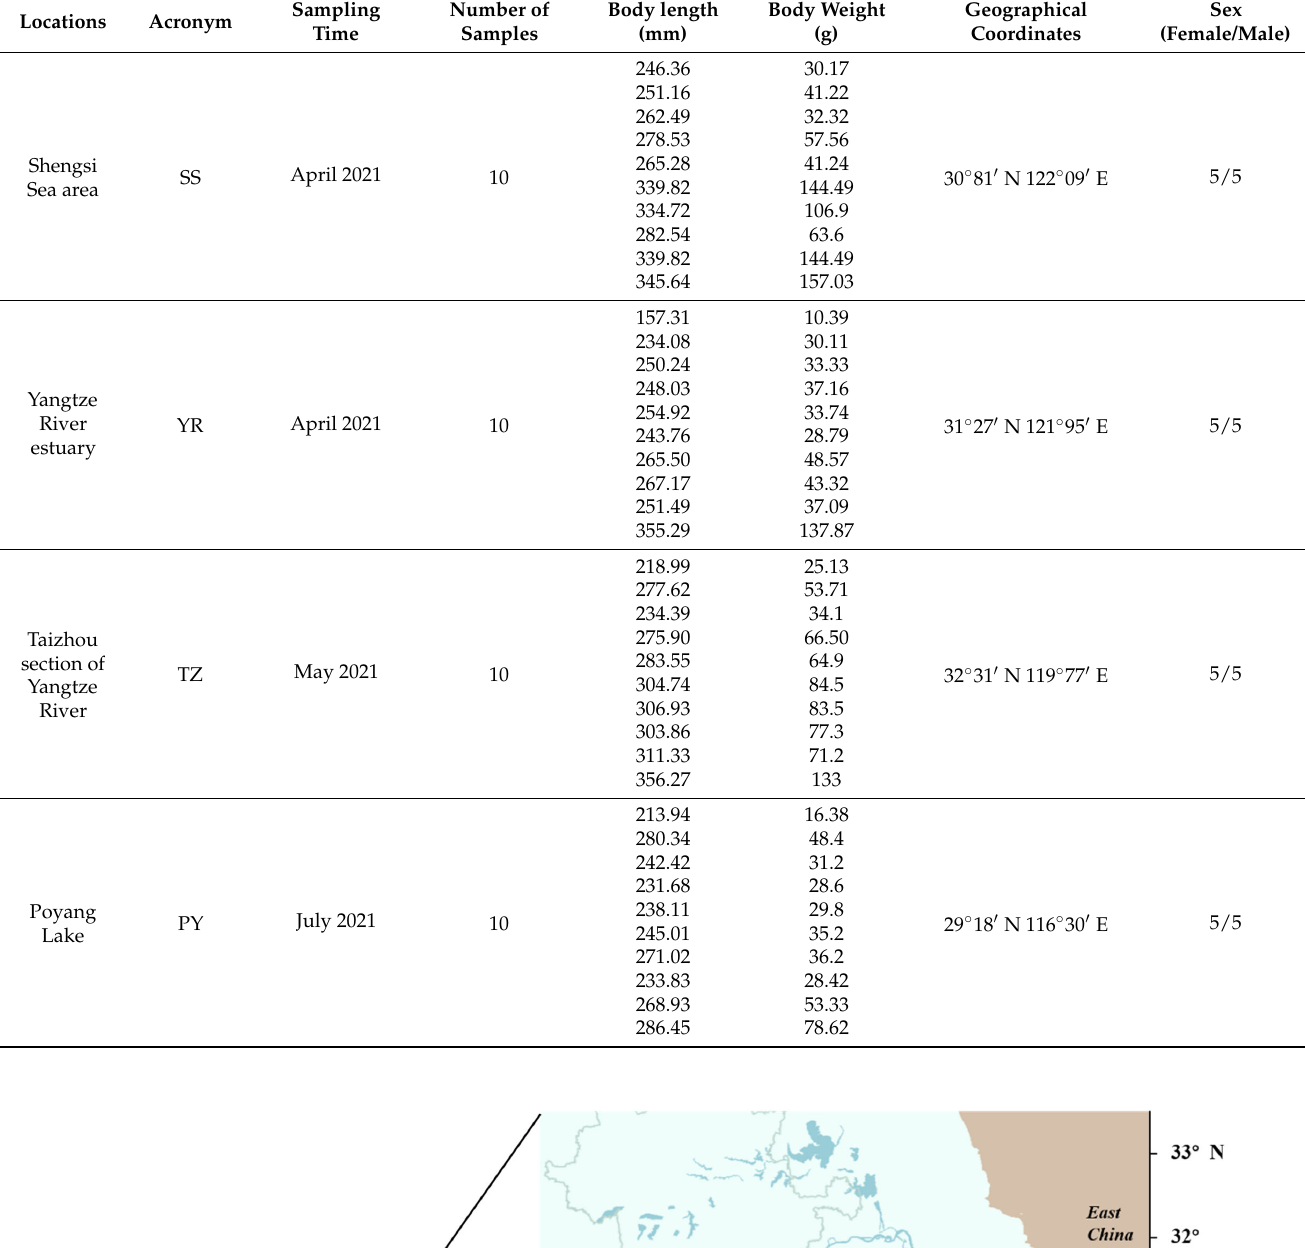
Table 1. Basic information of each population sample of Coilia nasus .